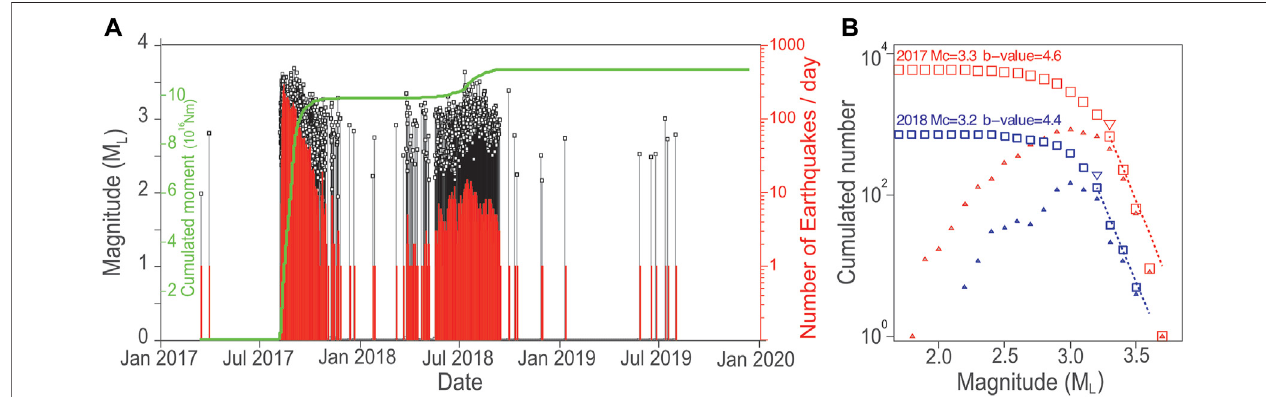
FIGURE 2 | Seismicity in the region affected by the swarm (source: NSC catalogue). (A) Magnitude versus time (in black). In red, the number of recorded earthquakesperdayversustime.Ingreen,cumulatedseismicmomentreleasedbytheearthquakes. (B) Cumulatednumberofeventsversuslocalmagnitudein2017(in red) and in 2018 (in blue). Triangles and squares correspond to the number of events and to the cumulated number of events above a given magnitude,